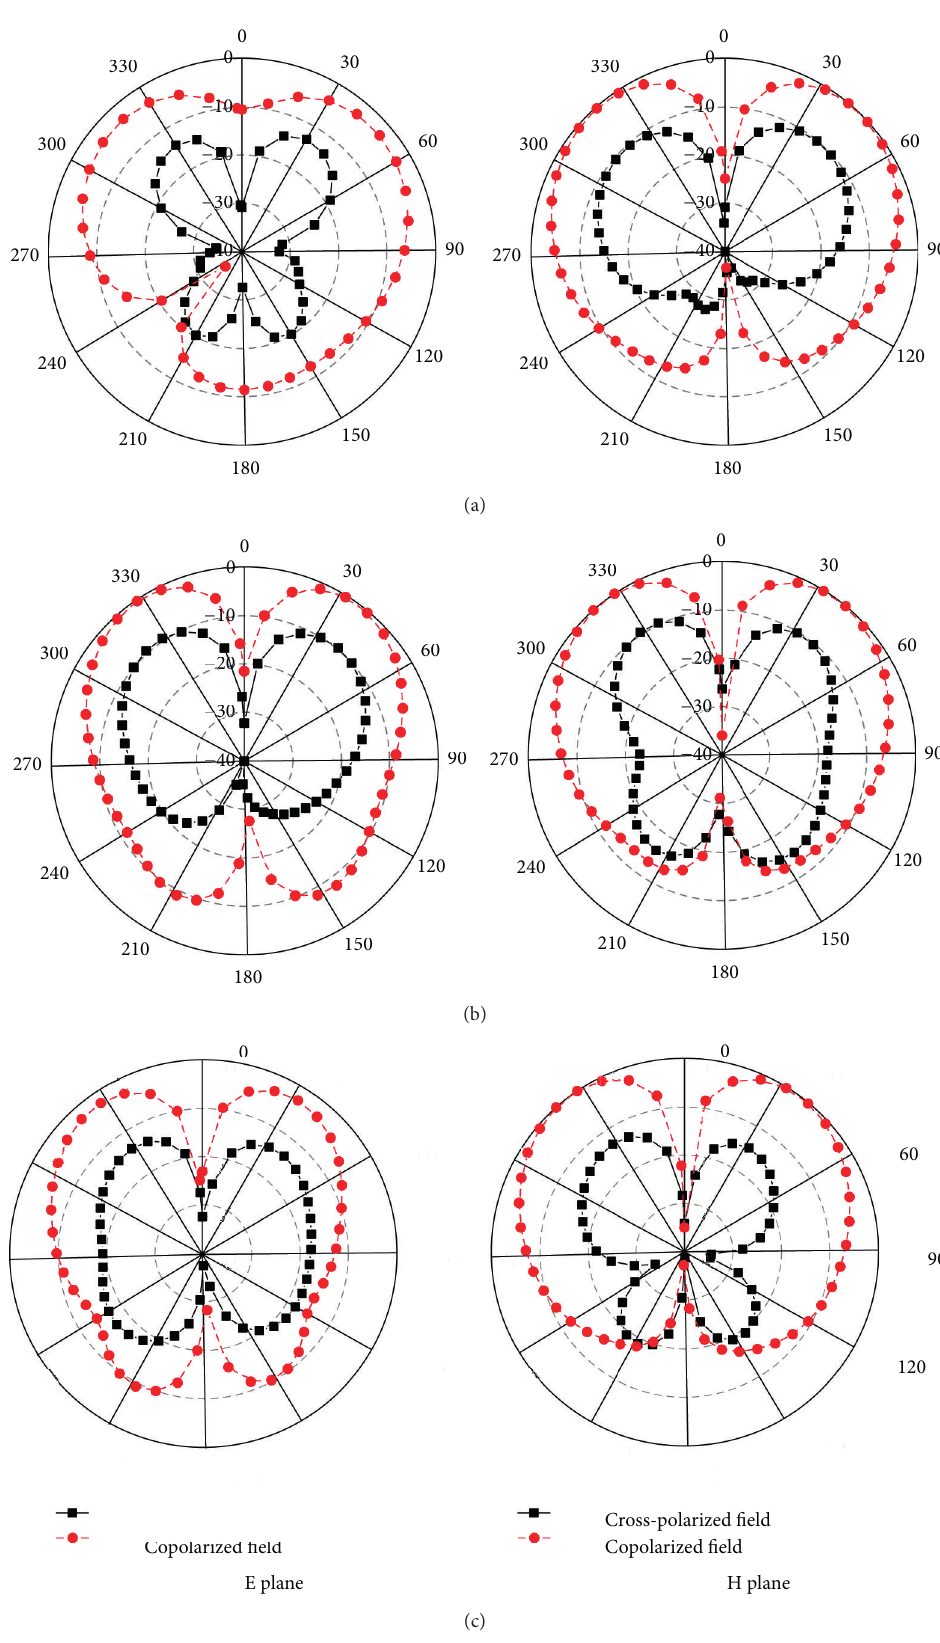
Figure 16: Radiation pattern at (a) 8.95 GHz, (b) 11.06GHz, and (c)